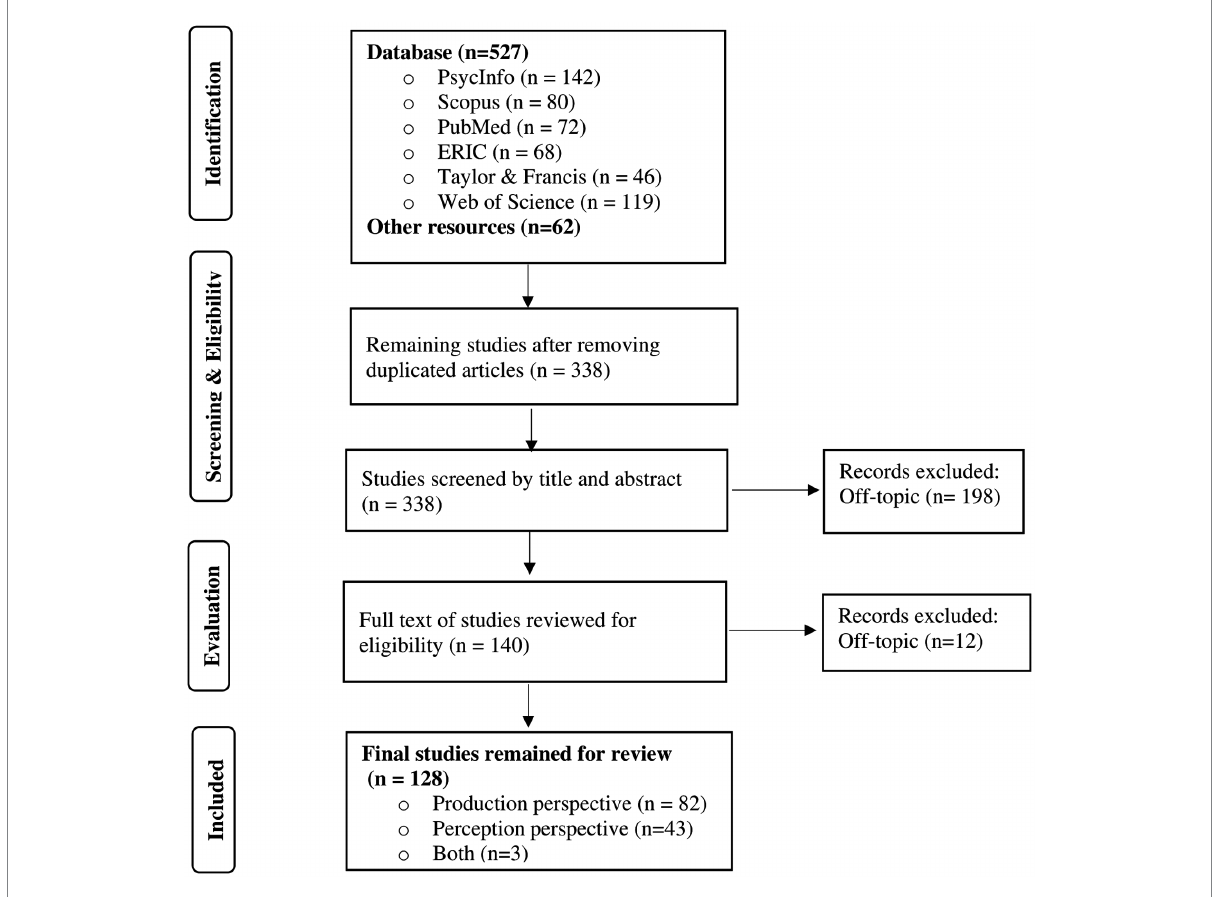
FIGURE 1 PRISMA flowchart of review